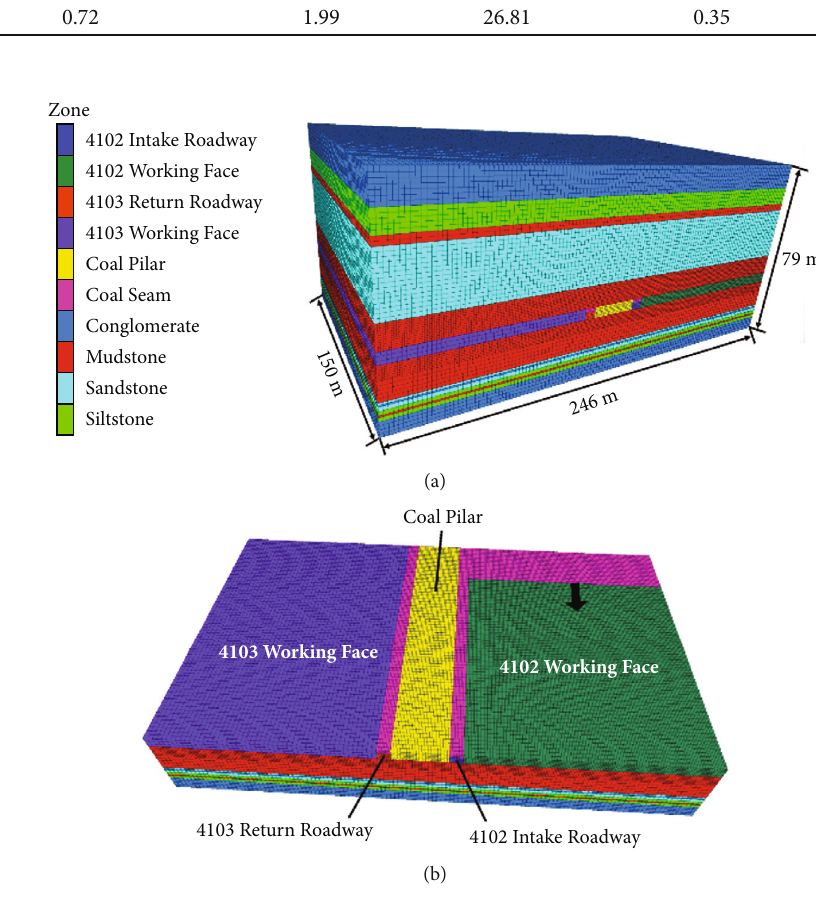
Figure 8: Geometric model of